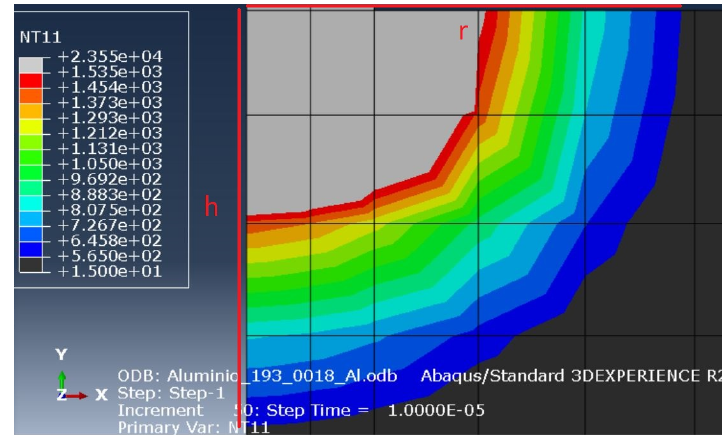
Figure 7. Measurement of the removed volume from the workpiece.